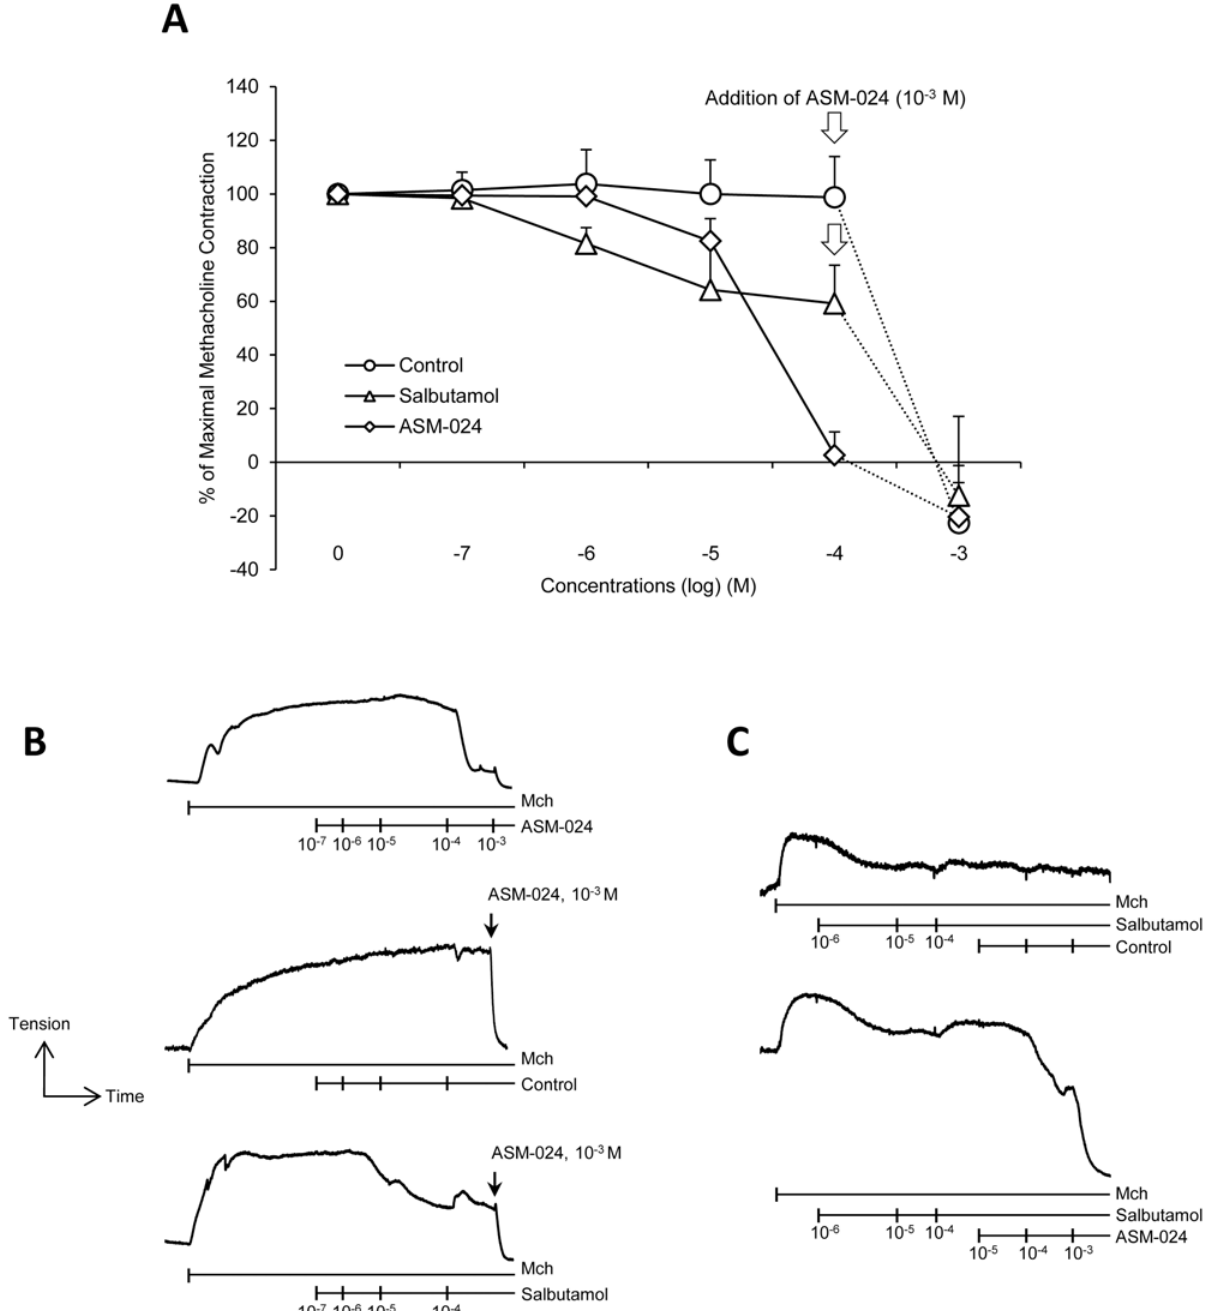
Fig 1. Additive effects of ASM-024 on beta2-agonists airway smooth muscle relaxation in dog bronchi. A) Dog bronchial preparations were contracted with 10 – 5 M methacholine and cumulative concentrations of ASM-024 or salbutamol added. ASM-024-induced bronchial relaxation required higher concentrations than the β 2-AR agonist salbutamol (EC50 = 45.21 ± 13.74 μ M for ASM-024 vs EC50 = 1.75 ± 1.83 μ M for salbutamol). Salbutamol decreased the tension of precontracted dog bronchi by a maximum of 53%; the addition of 10 – 3 M ASM-024 further relaxed bronchial rings to below the applied basal tension. B) Representative tension recording depicting relaxation of dog bronchi following cumulative concentrations of salbutamol and ASM-024. n = 4 – 6 bronchial preparations from 3 different dogs. C) Representative tension recording showing that salbutamol, at 10 – 6 M maximally decreased the tension of contracted human bronchi; the addition of 10 – 4 M and 10 – 3 M ASM-024 to the maximal effective concentration of salbutamol increased relaxation to below the applied basal tension.